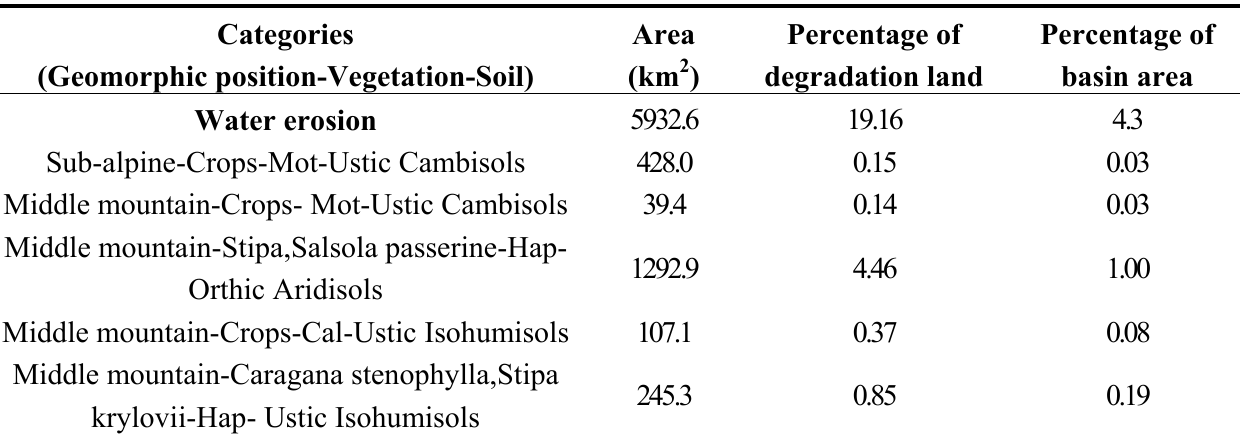
Table 2. Classification of degraded land in the Heihe River Basin of arid northwestern